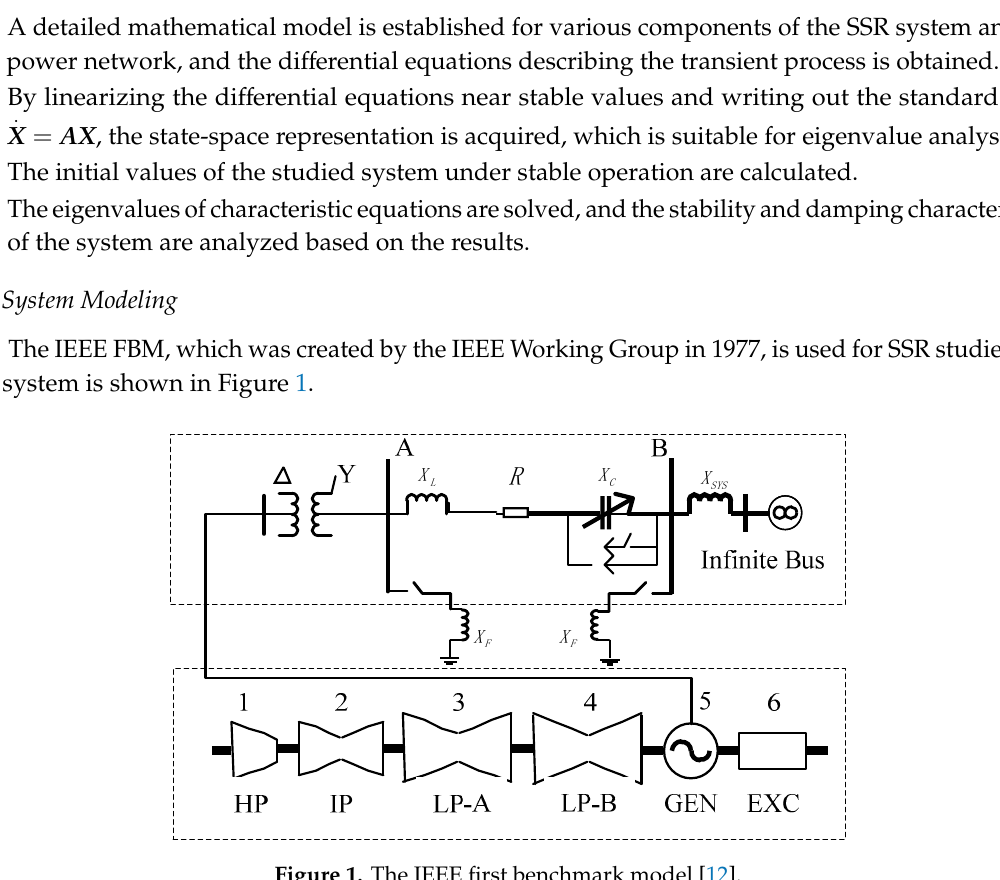
Figure 1. The IEEE first benchmark model [12].